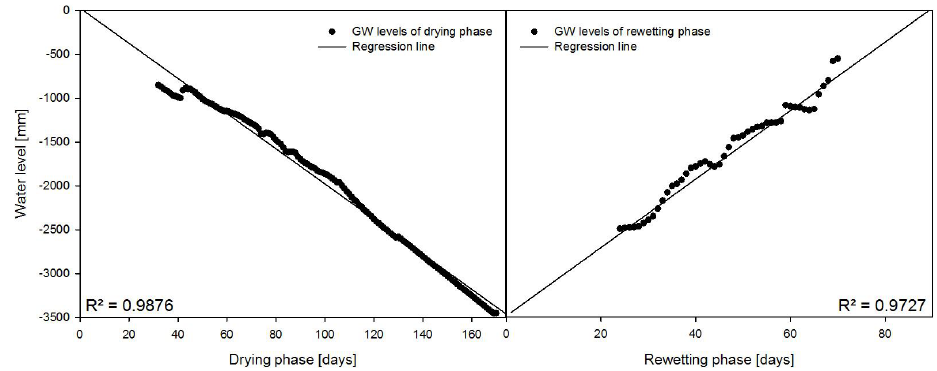
Figure 5. Measured and predicted groundwater levels of the drying and rewetting phases of location D (GW = groundwater).